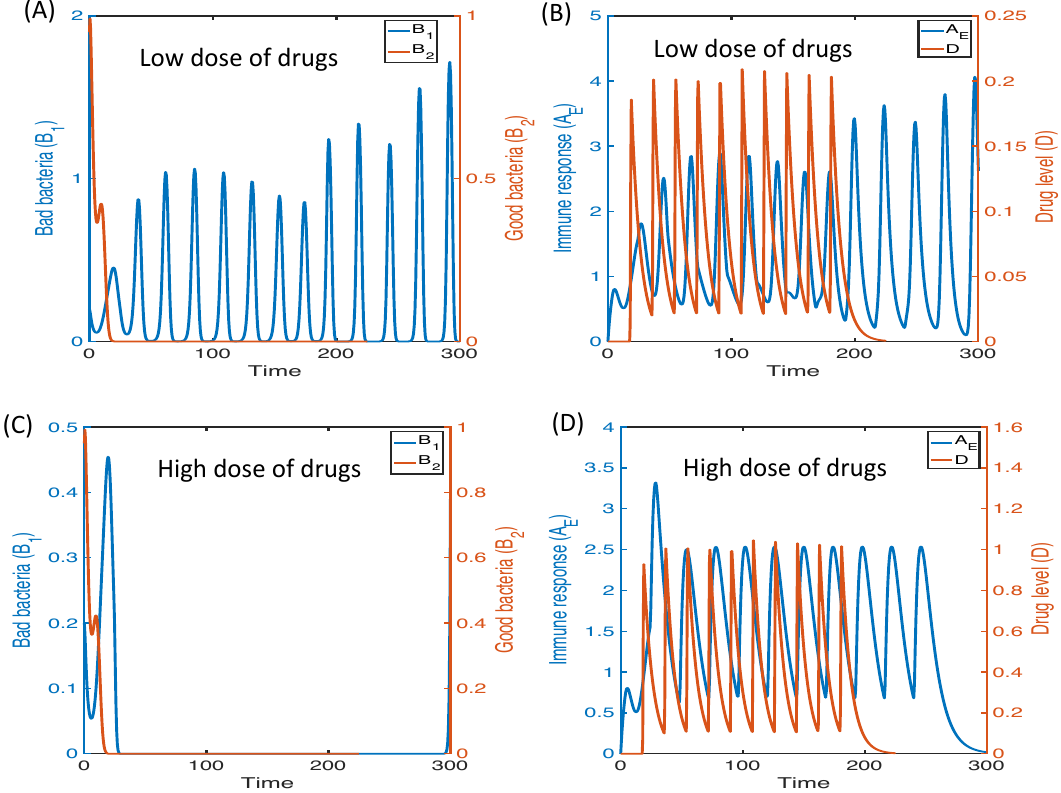
Figure 13. Dynamics of the system in response to low and high doses of drugs in the two-species M2 model (52)–(56). Immune activity was enhanced by the injection of drugs in a periodic fashion with an injection period 24 h ( τ D = 24 h ). ( A ) Time courses of populations of bad ( B 1 ) and good bacteria ( B 2 ) in response to periodic injection of drugs with a lower infusion rate λ D = 0.2 (duration t d = 1 h fixed); ( B ) time courses of immune response ( A E ) and drug levels ( D ) corresponding to (A); ( C ) time courses of populations of bad ( B 1 ) and good bacteria ( B 2 ) in response to periodic injection of drugs with higher infusion rate λ D = 1.0 (duration t d = 1 h ); ( D ) time courses of immune response ( A E ) and drug levels ( D ) corresponding to (C). Initial condition: B 1 ( 0 ) = 0.2, B 2 ( 0 ) = 0.95, A E ( 0 ) = 0.0, D ( 0 ) = 0. Parameter values: N D = 10, δ D = 0.1, τ 1 = τ 2 = 3.5; all other parameters are fixed as in Table 4 (Type